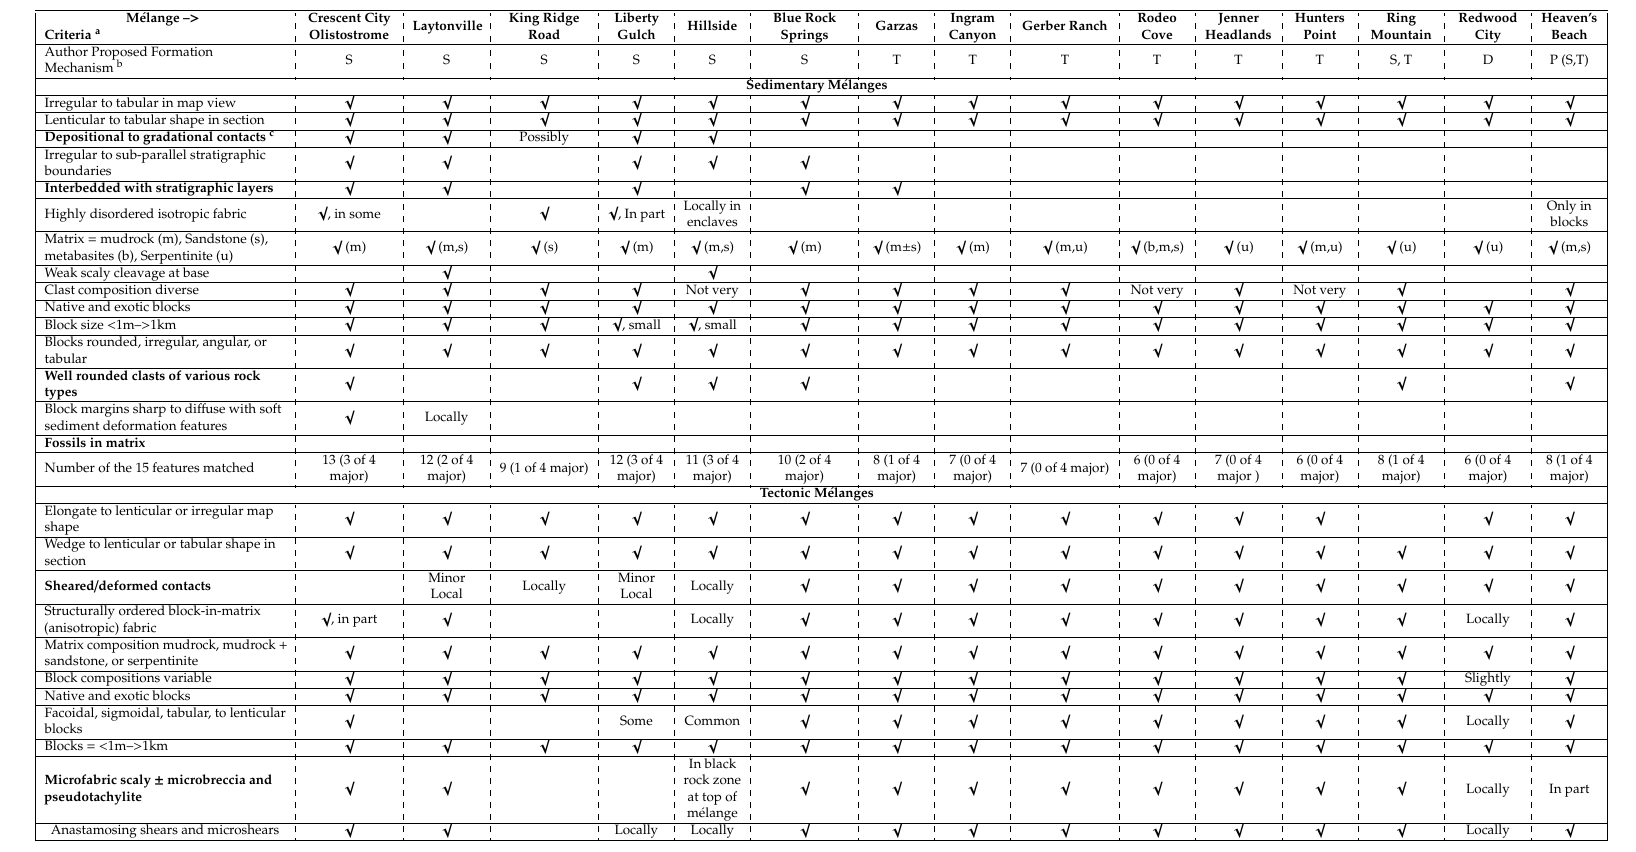
Table 1. Comparison of features and origins of selected Franciscan m é